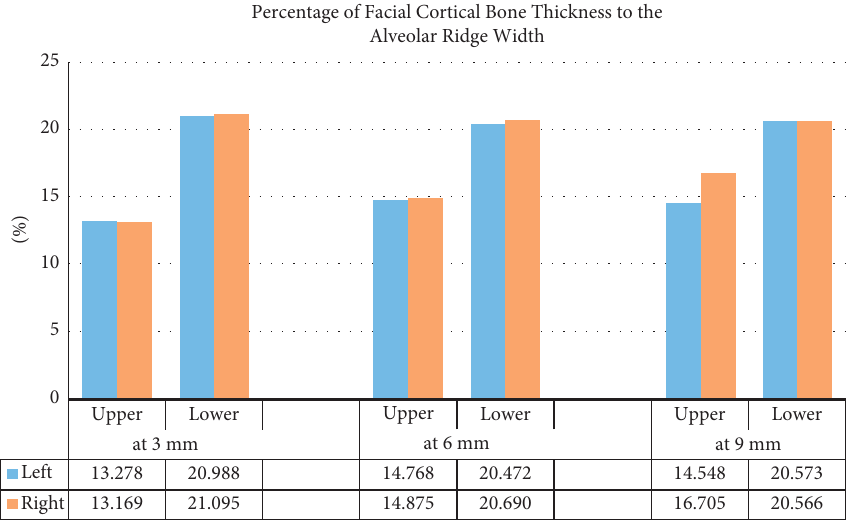
Figure 4: Percentage (%) of facial cortical bone width to alveolar bone width for the upper and lower central incisors (both sides) at 3 levels. Table 1: Bone density in Hounsfeld units measured at both maxilla and mandible. Te densities of cortical and cancellous bones were measured 5mm from the root apex of the coronal and interradicular regions between the two central incisors. Site Site P value N Facial cortical bone Palatal/lingual cortical bone Cancellous bone Maxilla 100 600.37 ± 126.63